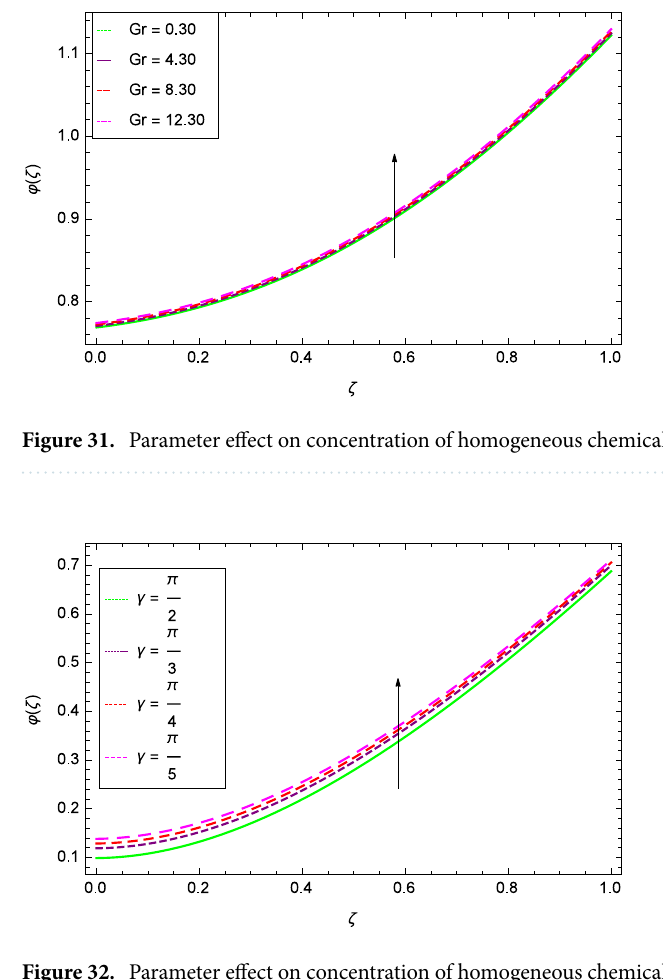
Figure 32. Parameter effect on concentration of homogeneous chemical reactions ϕ ( ζ ) profile.